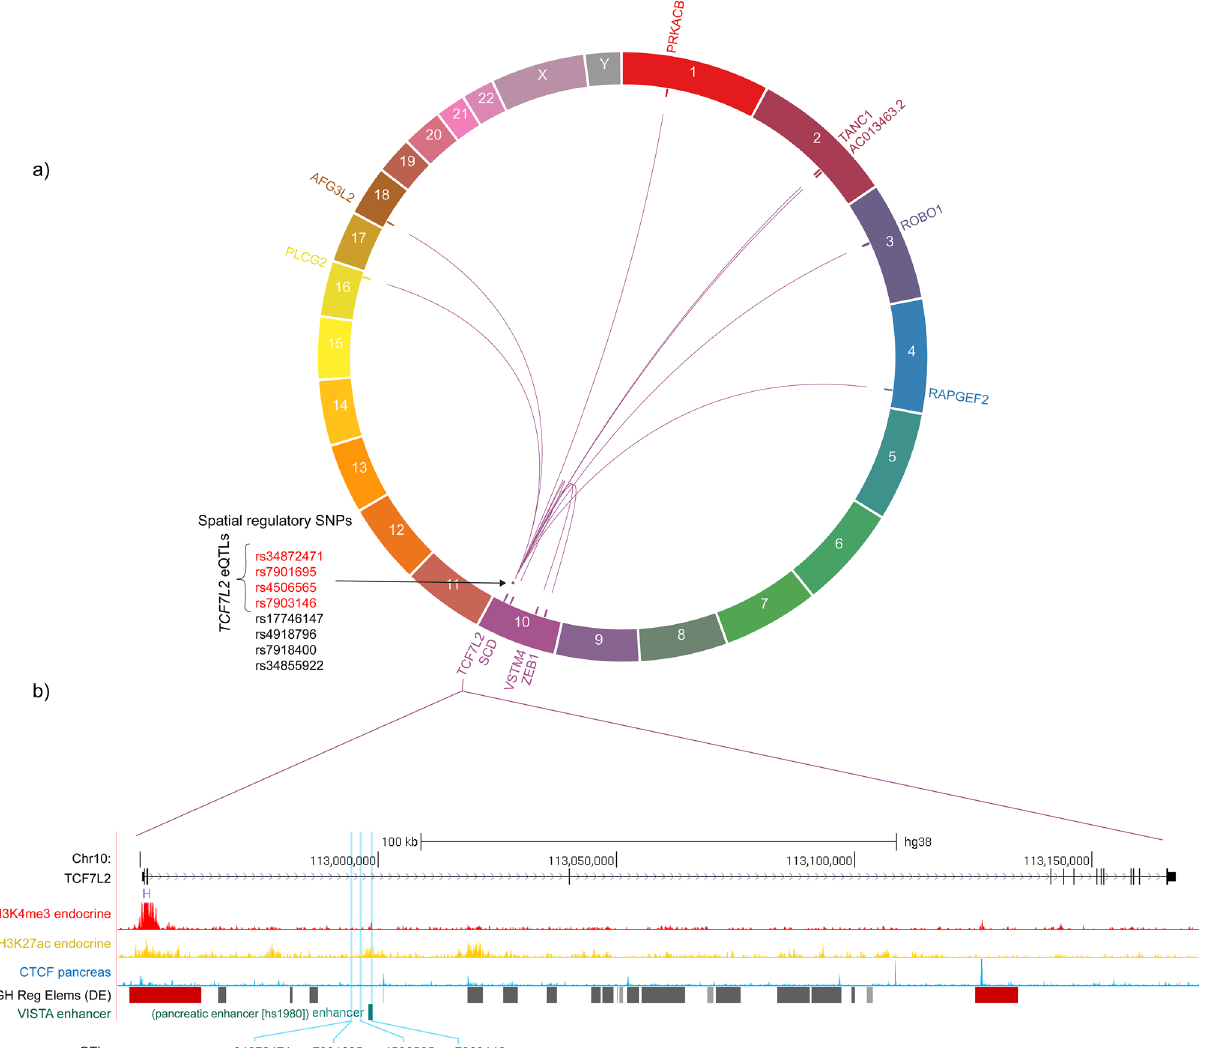
Figure 3. Regulatory SNPs within the TCF7L2 locus modulate the expression of genes involved in immune regulation and genes important for the etiology of T2D. ( a ) A circos plot of significant regulatory interactions (i.e. innermost link lines) between SNPs within the TCF7L2 locus (i.e. the pointed purple dot) and the spatially regulated genes (i.e. labelled genes in the outermost track) at FDR < 0.05. Spatial regulatory SNPs modulating the expression of TCF7L2 are highlighted. Linkage disequilibrium between genetic variants was obtained from https:// ldlink. nci. nih. gov/. ( b ) An expanded view of the TCF7L2 gene locus. SNP rs7903146 overlaps histone modification marks (i.e. pancreatic H3K4me3 and H3K27ac) and an annotated enhancer in the pancreas. Genome regulatory tracks were obtained from UCSC browser using hg38 coordinates chr10:112945186- 113172435 (https:// genome. ucsc. edu). GH Reg Elems (DE)—GeneHancer regulatory elements (double elite). Circa software was used to generate the circos plot and is available at http:// omgen omics. com/ circa/. The annotated pancreatic enhancer (hs1980) was extracted from VISTA enhancer database 94